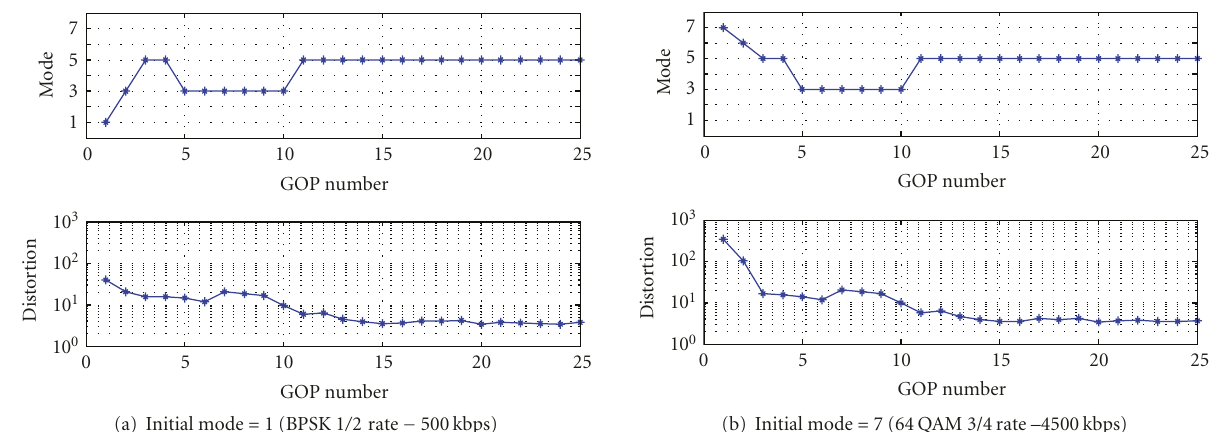
Figure 17: Mode and estimated distortion for table encoded with C/N = 21 dB, Set (c).